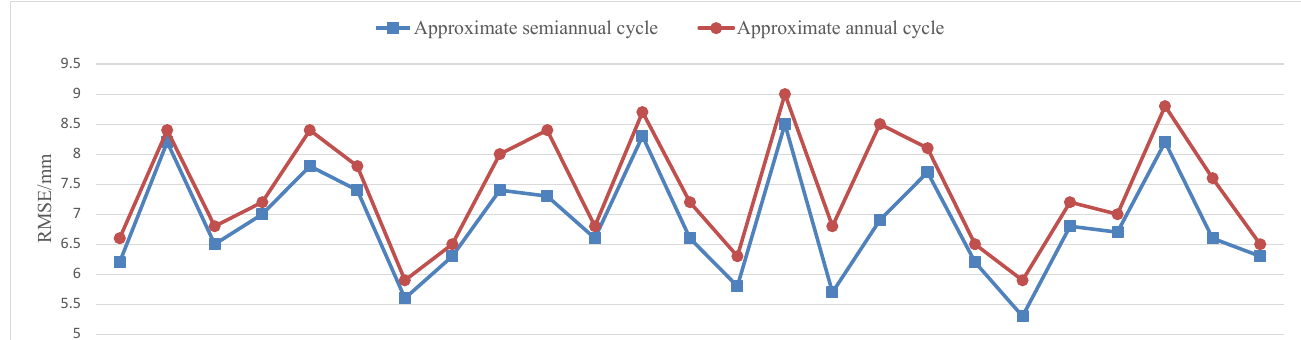
Figure 16. RMSE accuracy distribution of CORS station elevation nonlinear modeling residua based on GARCH+ nonlinear LS modeling.